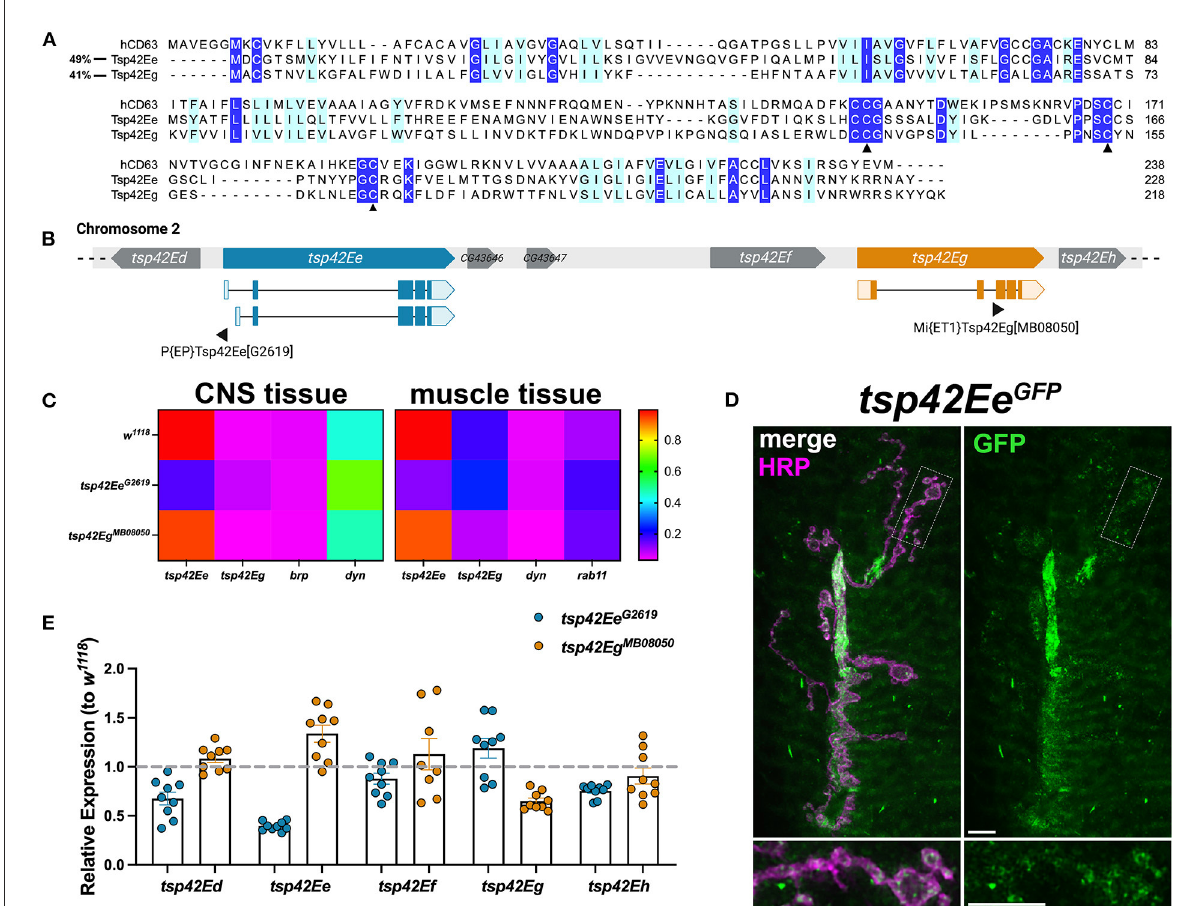
FIGURE1 Tsp42Ee and Tsp42Eg are CD63 homologs expressed at the Drosophila NMJ. (A) Multiple sequence alignment (Clustal Omega) of hCD63, Tsp42Ee, and Tsp42Eg. Identical residues (dark blue) and similar residues as determined by biochemical properties (light blue) are indicated. Arrowheads denote regions of critical motif conservation. (B) Arrangement of tsp genes ( tsp42Ed – tsp42Eh ) on Drosophila chromosome 2. Exonic regions of tsp42Ee and tsp42Eg are mapped with lighter shaded regions denoting 5’ and 3’ untranslated regions. Sites of transposon insertion for each tsp mutant construct are indicated below. (C) Heat maps of relative transcript expression in tsp42Ee G 2619 and tsp42Eg MB 08050 CNS and muscle tissue relative to controls ( w 1118 ). (D) Representative confocal image of the 6/7 NMJ showing the localization of GFP-tagged Tsp42Ee (green) in presynaptic terminal boutons (magenta, HRP). Scale bar = 5 µ M. (E) Histograms of tsp transcript expression in tsp42Ee G 2619 and tsp42Eg MB 08050 whole larvae relative to controls ( w 1118 ; dashed line). Each point represents one technical replicate. Error bars represent SEM.